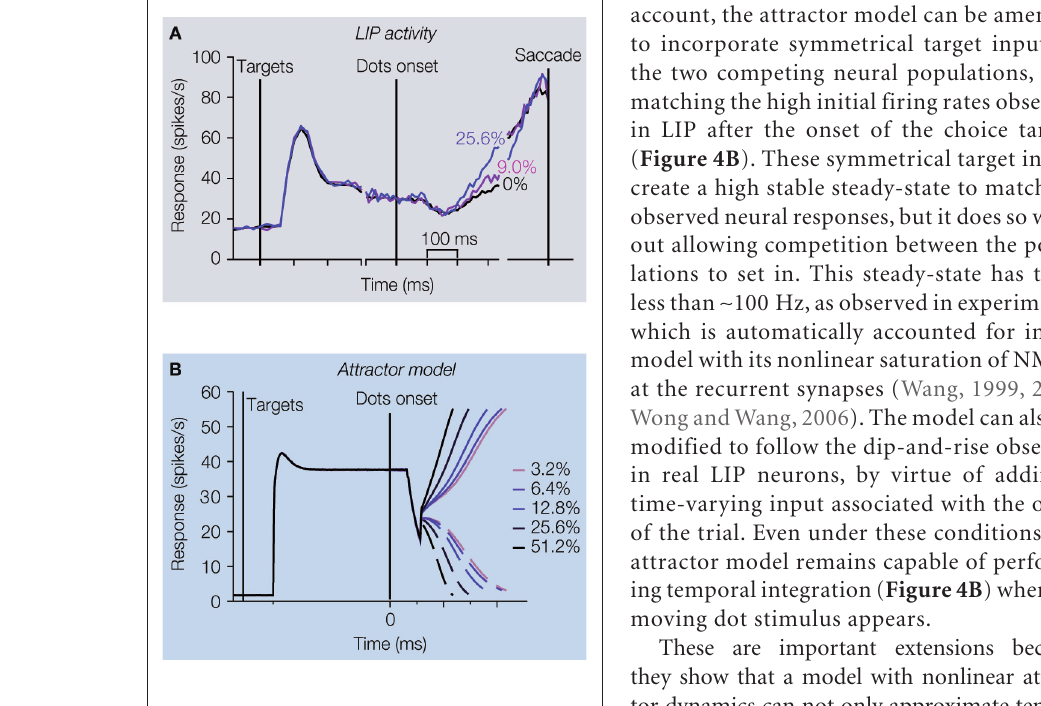
Figure 4 | Other temporal dynamics observed in the direction-discrimination protocol. (A) Dynamics of population-averaged LIP firing rate throughout a trial in a 4-choice reaction time task (Churchland et al., 2008), similar to Roitman and Shadlen (2002). Note the high firing rate right after choice targets onset and the signature dip-and-rise before ramping of activity after motion onset. Only saccades into the response field of LIP neurons are shown. (B) Attractor network model of Wong et al. (2007) that reproduces similar features as in the monkey experiments. Trial-averaged neural responses. (A) adapted from Churchland et al. (2008), with permission; (B) from Wong et al.